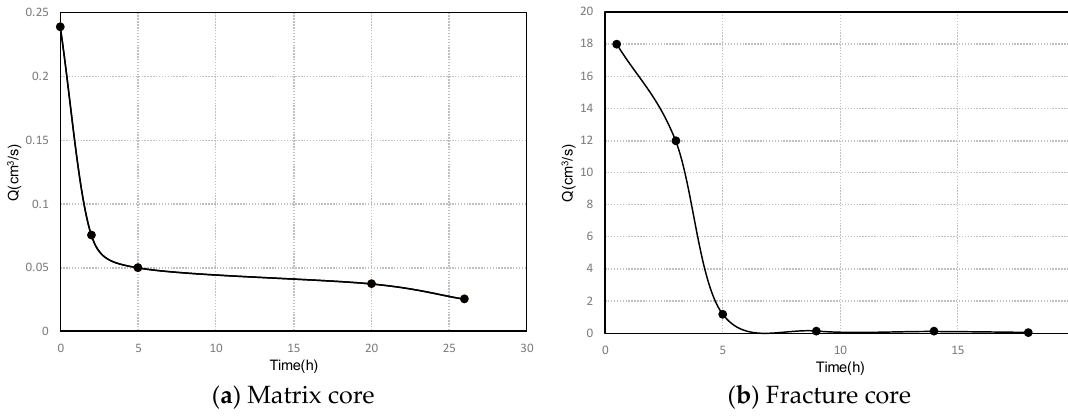
Figure 7. The relationship between injection flow rate and time, pressure = 3.8 MPa.